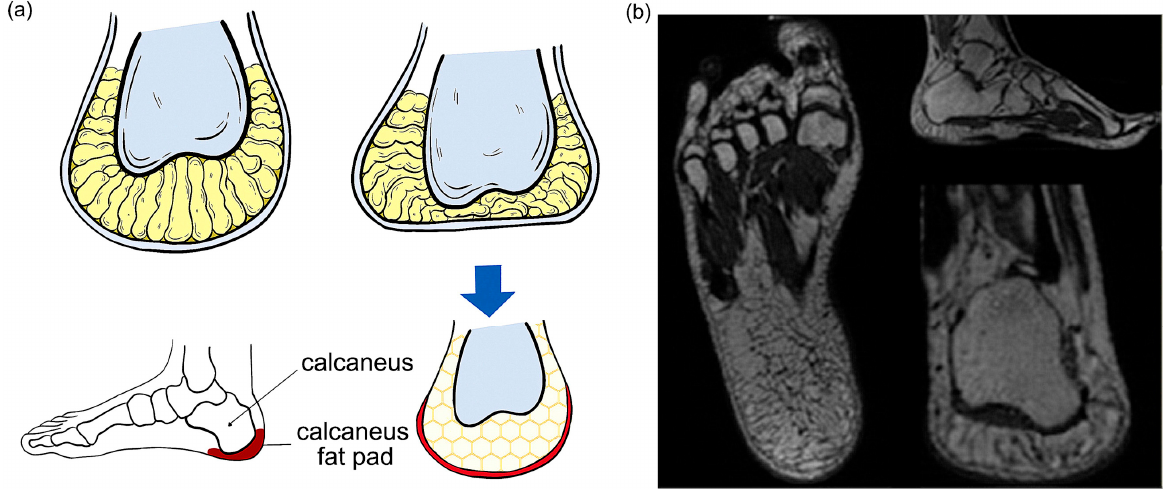
Figure 1. Human heel pad and its magnetic resonance imaging (MRI) images. ( a ) Indication of nonstress and stress on the heel pad of the normal foot. The position and the honeycomb structure of the heel pad were depicted; ( b ) MRI image of the human heel pad.